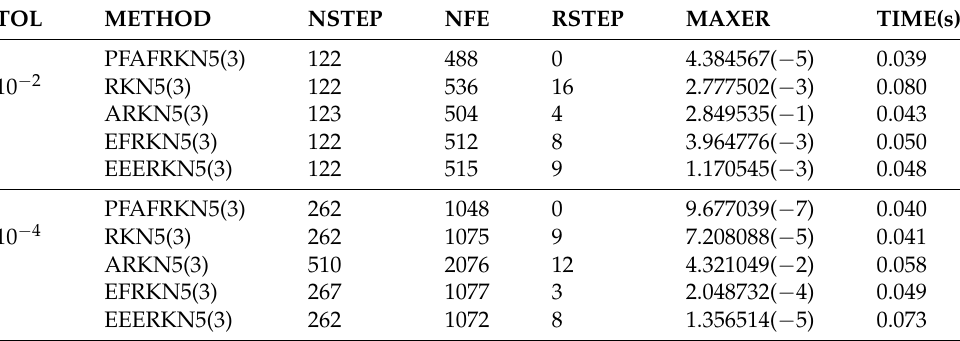
Table 4. Numerical data corresponding to Problem